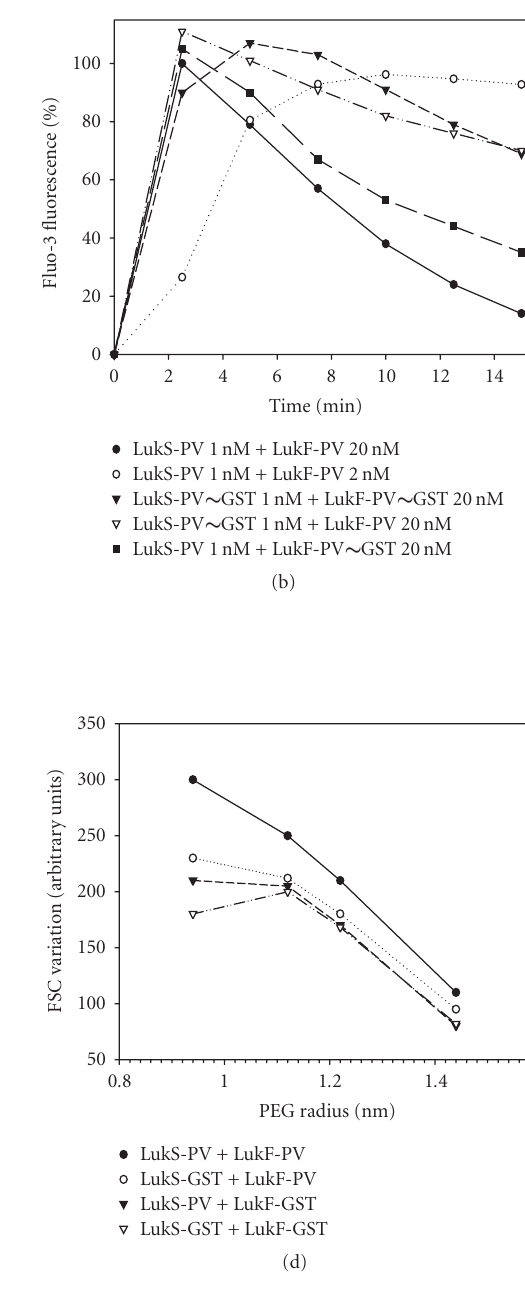
Figure 2: Biological activity of GST fusion proteins. (a) Control of homogeneity by 3%–8% (w/vol) SDS-PAGE of 200ng of each purified protein is shown; (1) molecular ladder, (2) LukF-PV, (3) GST ∼ LukF-PV, (4) LukS-PV, (5) GST ∼ LukS-PV. (b) Flow cytometry evaluation of the Ca 2+ entry into human PMNs mediated by combinations of wild-type LukS-PV and LukF-PV and GST fusion proteins. (c) Flow cy- tometry evaluation of the ethidium entry into human PMNs mediated by combinations of LukS-PV and LukF-PV and GST fusion proteins. (d) Hydrodynamic radius of pores formed by WT and fusion proteins in human PMNs determined after a 30-minute incubation of toxins (20nM of S and 100 nM of F components). Osmotic protection by polyethylene glycol molecules was assessed by variations of the mean FSC (forward light scatter) value in the presence of PEG molecules of di ff erent hydrodynamic radii. demonstrated to be independent [7, 24]. Fusion